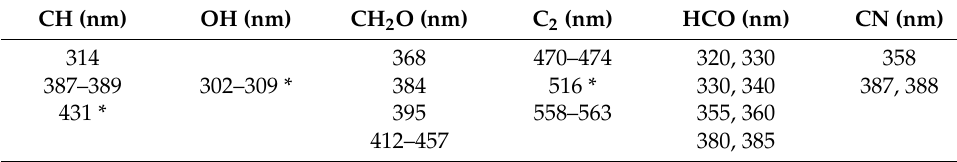
Table 9. Emission peaks of major combustion species determined in the